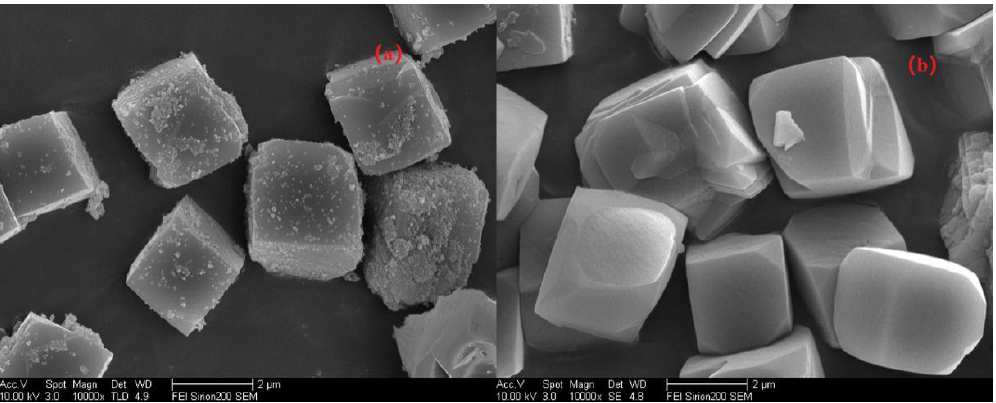
Figure 5. SEM images of S-12 ( a ) and S-14 ( b ).